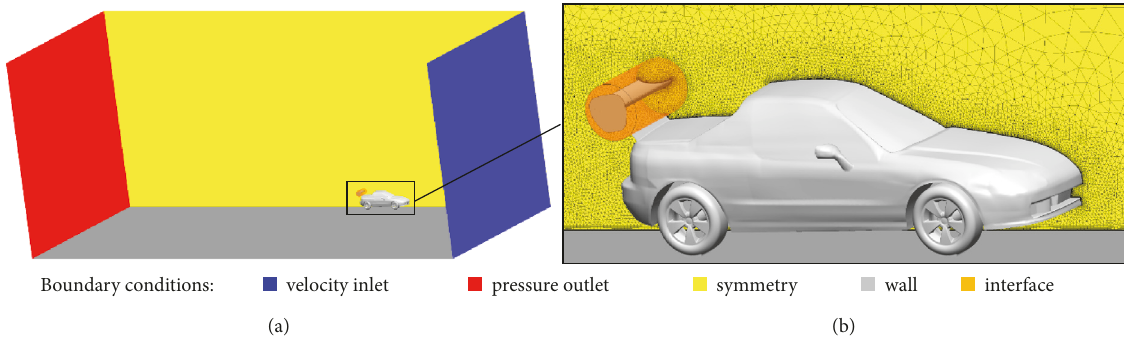
Figure 10: (a) Geometry of the computational domain. (b) Close-up on the car body with mesh on the symmetry